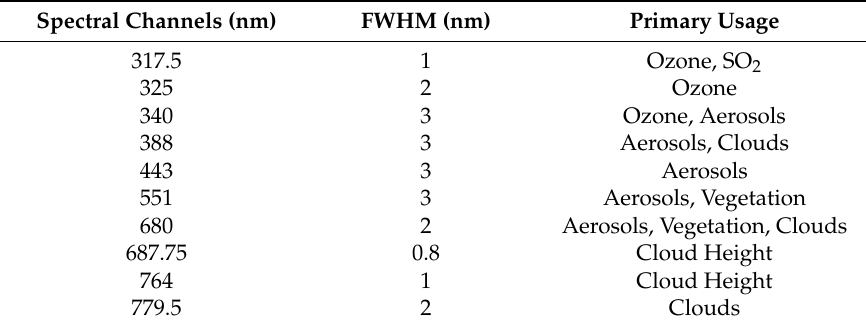
Table 1. Specifications of 10 EPIC channels and their primary